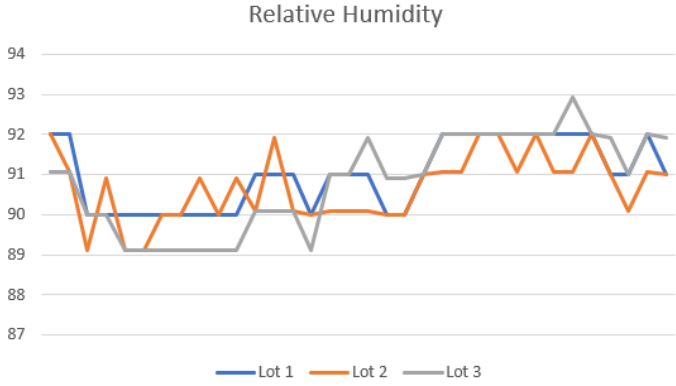
Figure 10. Relative humidity using the IoTCocoa